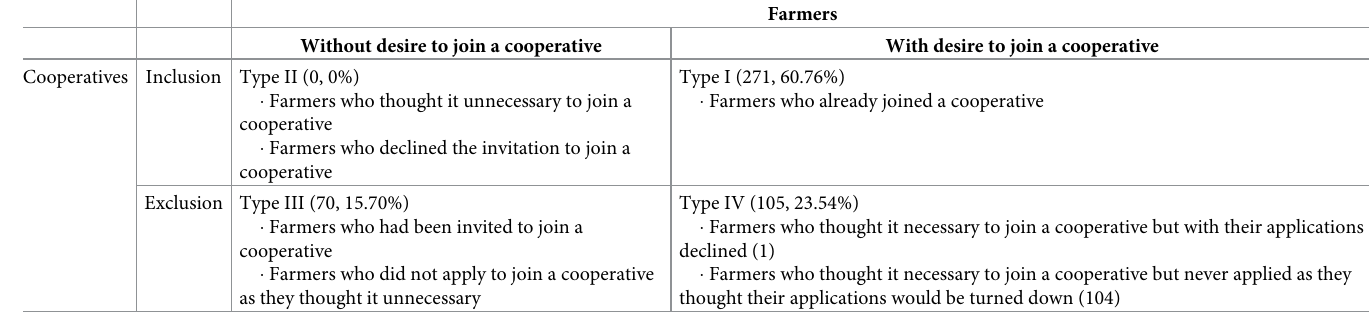
Table 2. Classification of the sample farmers.